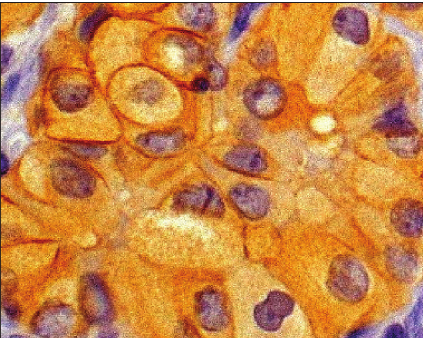
Figure 2: Higher magnification showing concurrent cytoplasmic and cell membrane immunostaining for TfR1/CD71 in